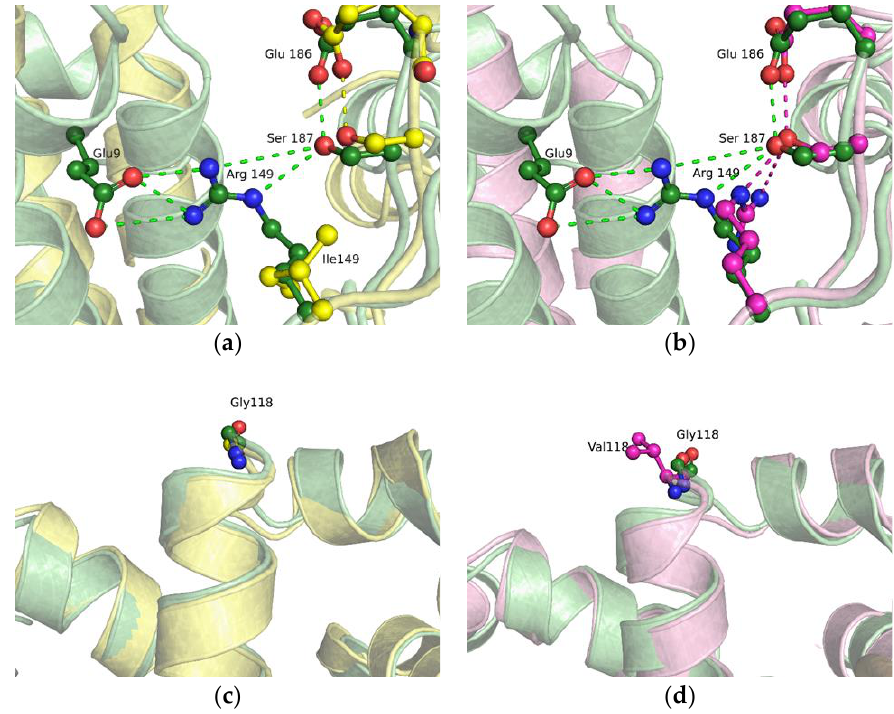
Figure 6. An overlay of WT Pol β (green), G118V (magenta), and R149I (yellow) snapshots of the Arg149 region ( a , b ) or Gly118 region ( c , d ) in the binary enzyme–DNA complex. Hydrogen bonds are presented as dashed lines.